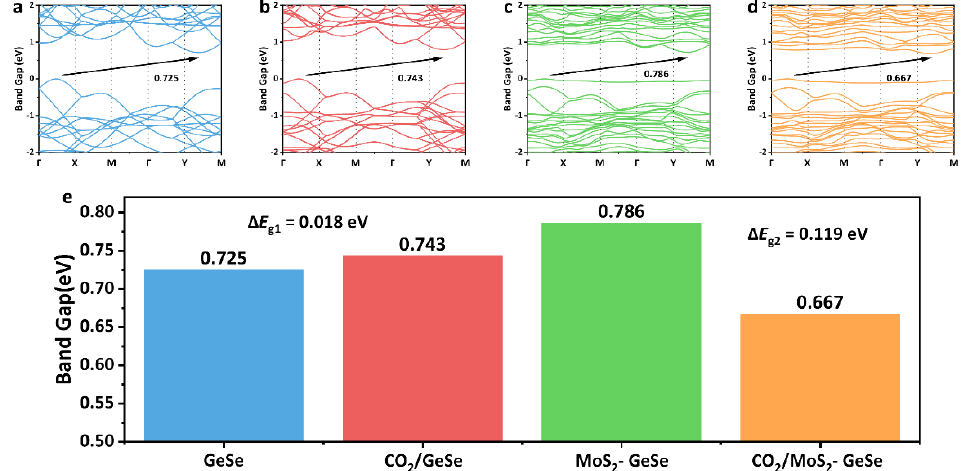
Figure 4. The E g values of the pure GeSe monolayer ( a ), the CO 2 /GeSe monolayer ( b ), the MoS 2 – GeSe monolayer ( c ) and the CO 2 /MoS 2 –GeSe monolayer ( d ); the change trend of E g ( e